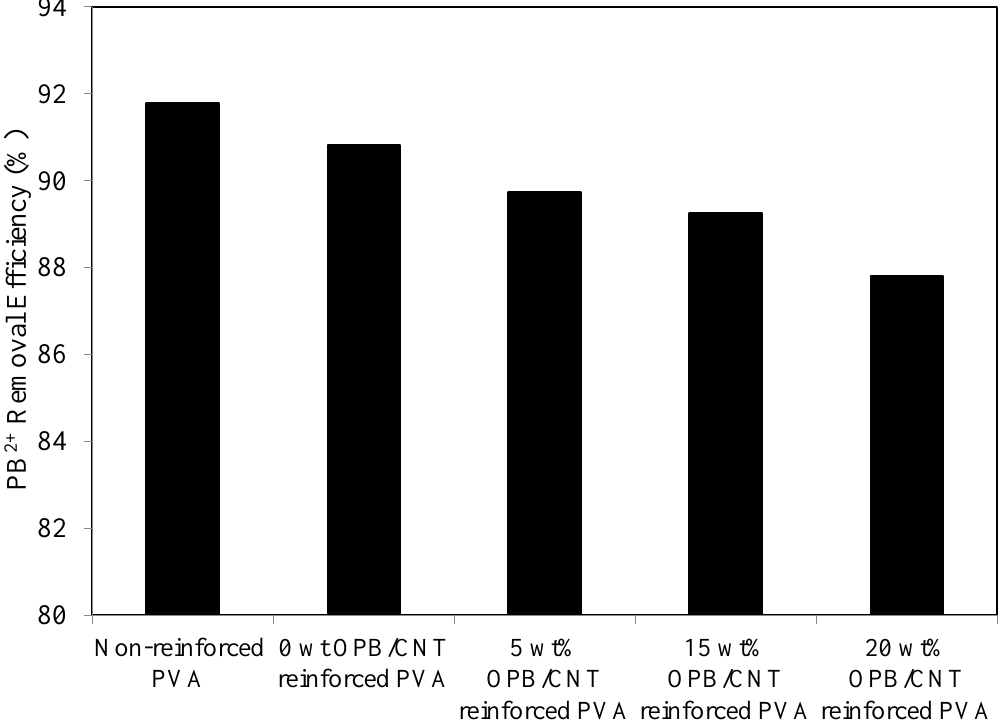
Figure 7. Pb(II) ions removal of non-reinforced and PVA hydrogels with 4 wt % MWCNTs at different amount of OPB. Experimental conditions: adsorbent dose = 0.5 g, Pb(II) concentration = 65 mg/L, pH = 7 and maximum adsorption time = 300 min (1, 3, 5, 10, 20, 30, 60, 120, 180, 240 and 300 min) at room temperature.